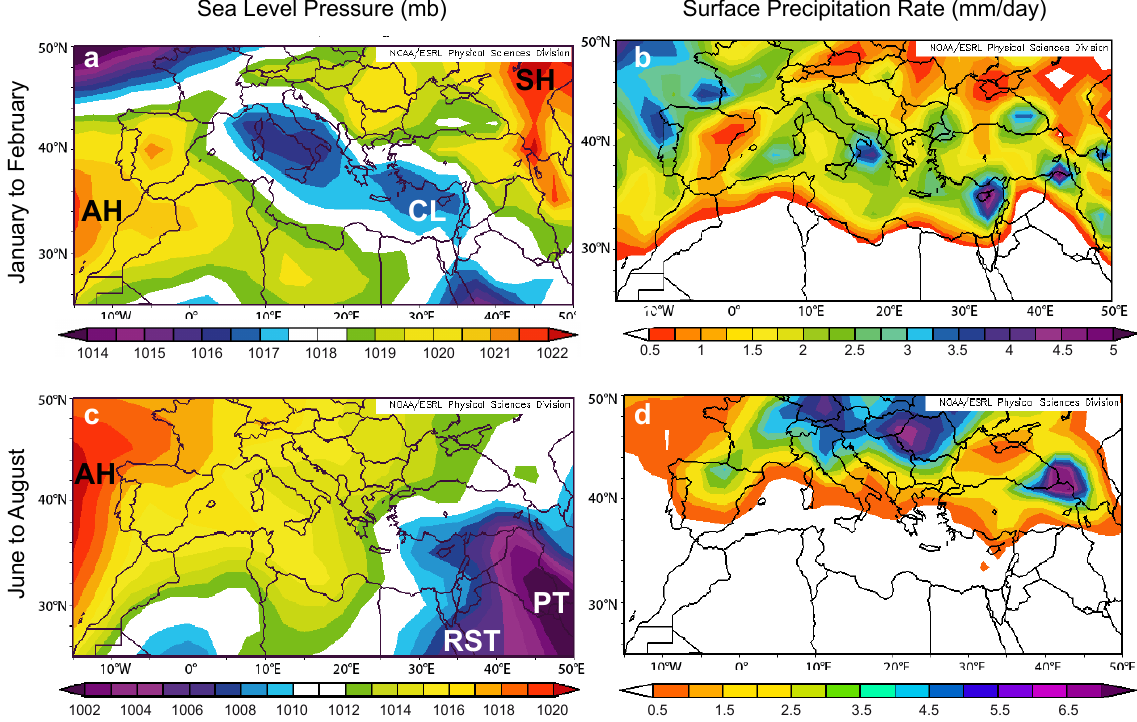
Fig. 2. Sea level pressure and surface precipitation rate in the Mediterranean region in winter – January–February: (a) , (b) – and summer – June–August: (c) , (d) – averaged from 1968 to 1996. Source: NCEP/NCAR Reanalysis. NCAA/ESLP Physical Sciences Division (http://www.cdc.noaa.gov/Composites/Day/). AH: Azores High; SH: Siberian High; CL: Cyprus Low; RST: Red Sea Trough; PT: Persian